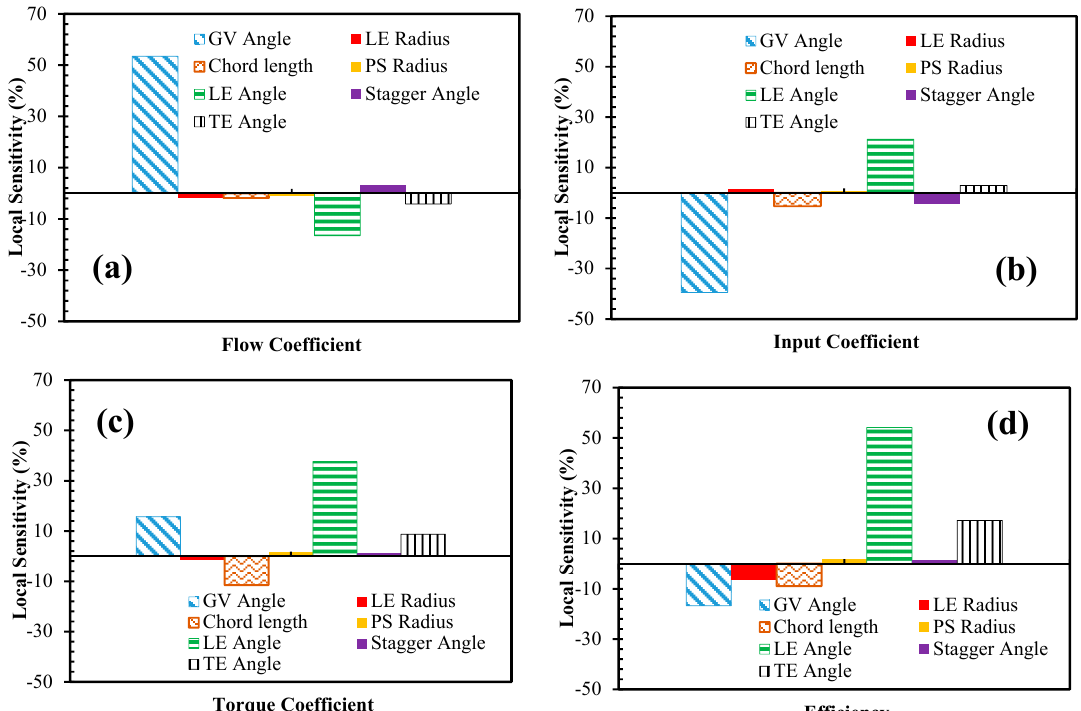
Figure 10. Local sensitivity of input parameters at the optimum design point. Local sensitivity of the input parameters on the: ( a ): Flow coefficient; ( b ) Input coefficient; ( c ) Torque coefficient; ( d ) Efficiency.